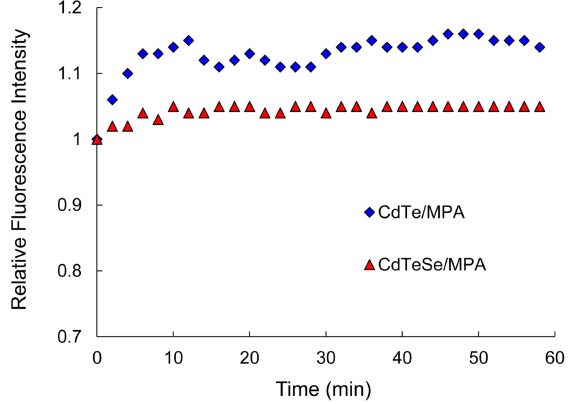
Figure 3. Photostability of the MPA-capped CdTe and the MPA-capped CdTeSe QDs in water at pH 8 under UV light irradiation.